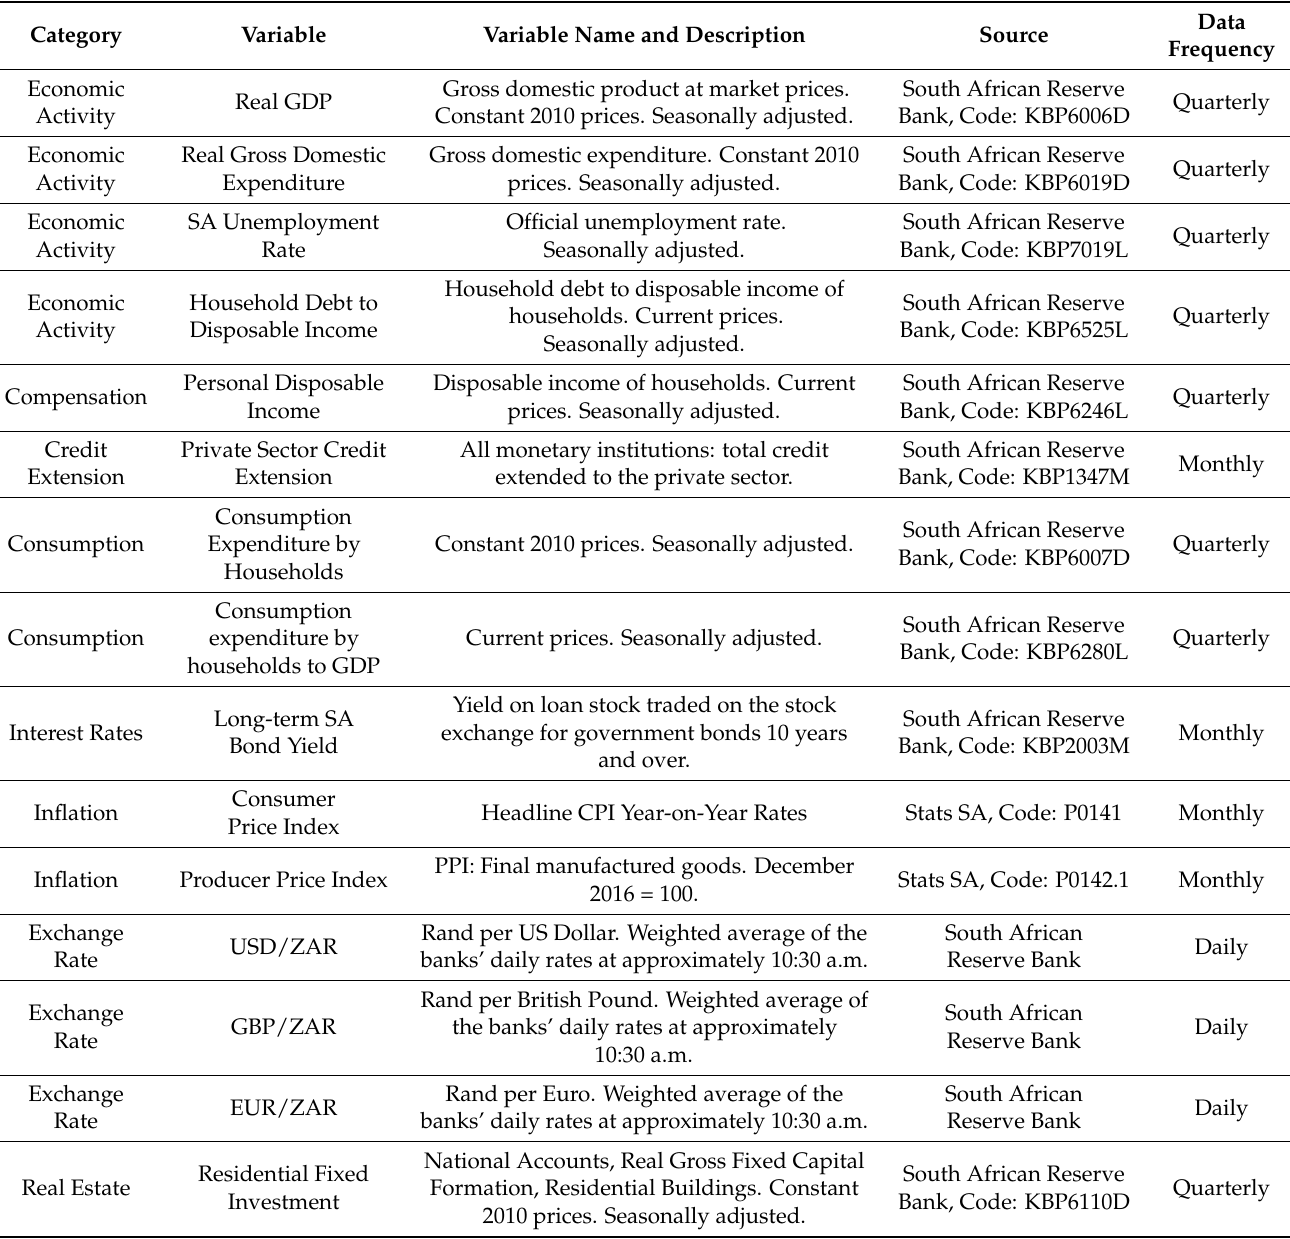
Table A1. Description of the South African variables used in the